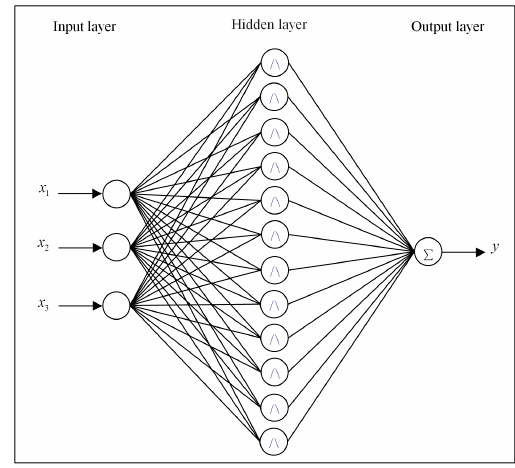
Figure 5. Neural network model.